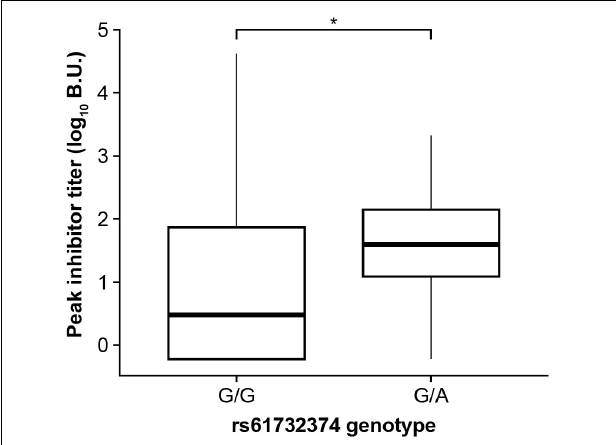
FIGURE 4 | The GRID2IP rs61732374-A allele is associated with increased peak inhibitor titer. Significance was evaluated using a linear regression model adjusting for age, hemophilia A severity, F8 mutation type, and genetic ancestry group. Inhibitor titers were log transformed prior to association testing. The analysis included black or African American as well as European ancestry participants with history of inhibitors (current or past) and available peak inhibitor titer information ( N = 310). The analysis could not be performed in the Hispanic, Latino/a, or Spanish group as the A-allele was not observed in this population. BU, Bethesda Units. * P <